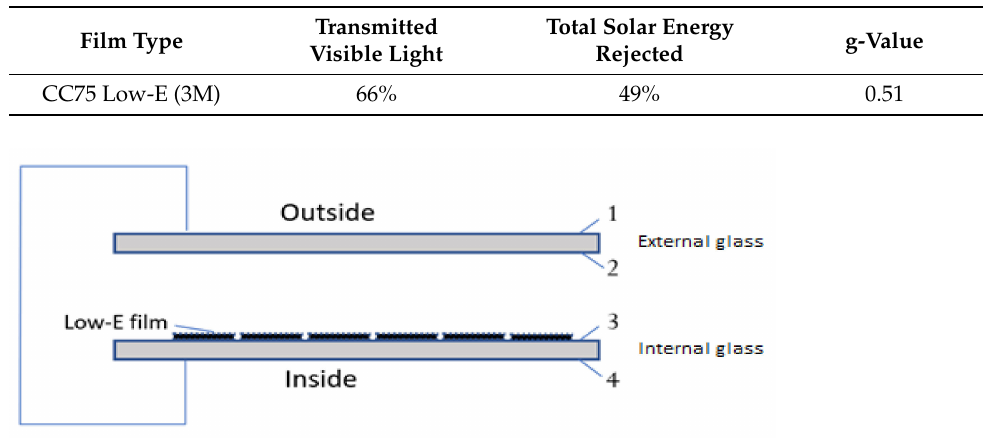
Table 5. Window film specification applied to a double-clear glazed window, published by the manufacturer.